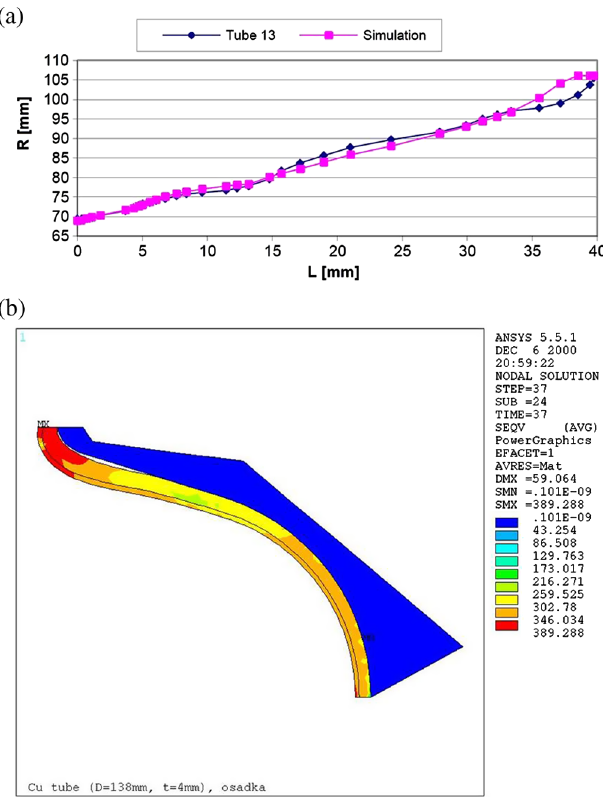
FIG. 5. (a) Simulation of radius growth during hydroforming in comparison with experiment (Tube 13). (b) Calculated stress distribution after hydroforming.